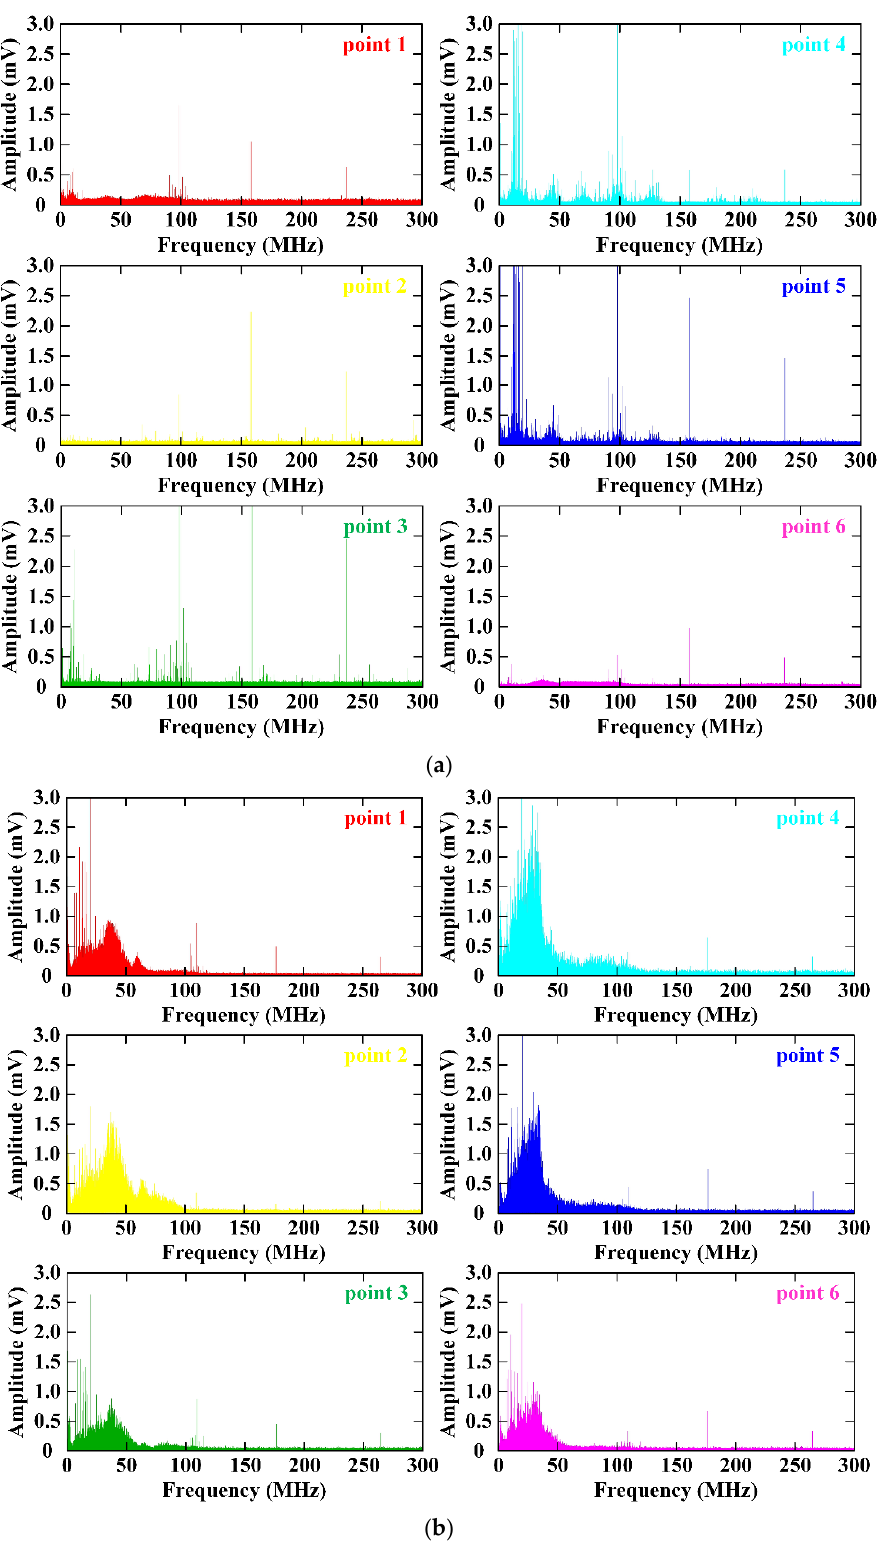
Figure 6. Electromagnetic radiation spectrum of TNT explosion. ( a ) Frequency distribution of electromagnetic radiation of 30 kg TNT; ( b ) frequency distribution of electromagnetic radiation of 60 kg TNT.